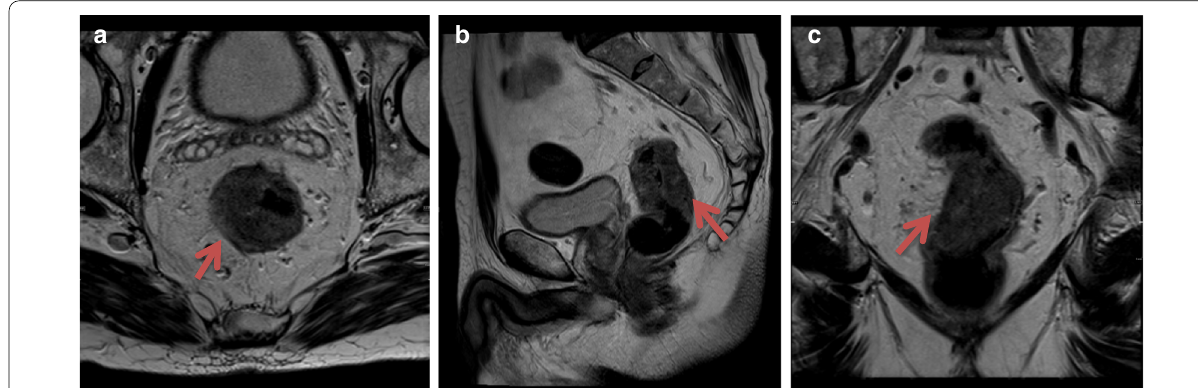
Fig. 24 Rectal adenocarcinoma Axial, sagittal and coronal T2-weighted images showing a semi-annular mass (red arrow), posterior to the prostate and within the rectum which is T2 hyperintense to gluteal muscle and extending from 3 to 1 o’clock causing significant luminal narrowing. Colonoscopy and biopsy proved rectal adenocarcinoma